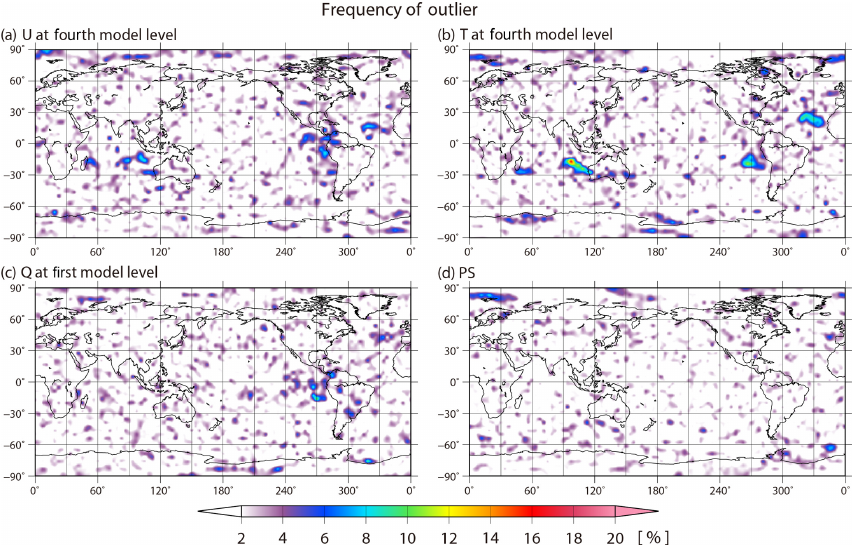
Figure 9. Similar to Fig. 8, but showing the frequency of identifying at least one outlier with high a LOF>8.0 on a 10240-member ensemble.